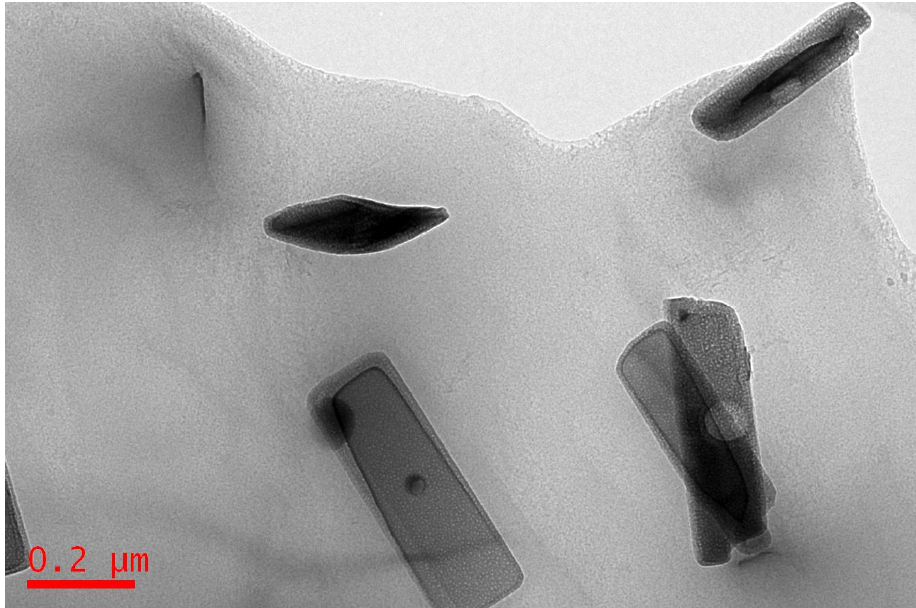
Figure 11. TEM bright-field image and precipitated phase of Al clad sheets (core layer). (aged state).